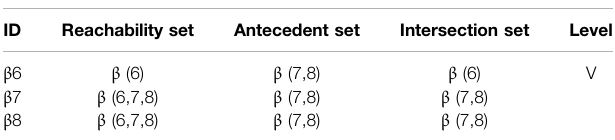
TABLE 9 | Partition level III.